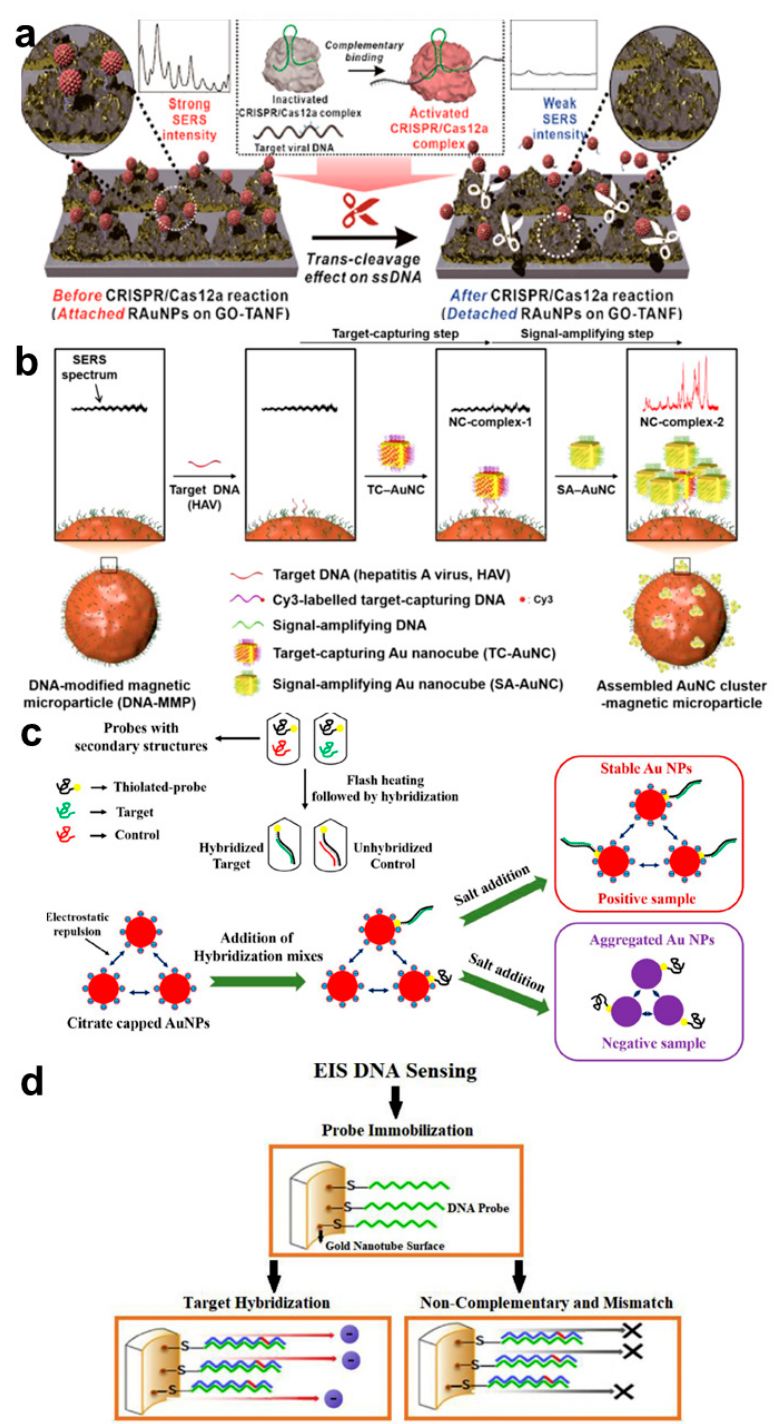
Figure 2. Viral DNA-target SERS and electrochemical biosensors using plasmonic nanomaterials: ( a ) Schematic diagram of the SERS-active viral DNAs detection platform using rough-faced Au nanostructure with GO and Raman dye-functionalized AuNPs. This figure is reproduced from [55] (© 2022 American Chemical Society); ( b ) Schematics of the SERS-based sensitive DNA detection using hierarchic interfacial Au nanocube assembly. This figure is reproduced from [58] (© 2022 American Chemical Society); ( c ) Plasmonic AuNPs-assisted colorimetric biosensor for detection of HCV DNA. This figure is reproduced from [64] (© 2022 Springer); ( d ) Nanoporous Au nanotube- based electrochemical impedance spectroscopy (EIS) biosensors. This figure is reproduced from [65] (© 2022 Elsevier B.V.)